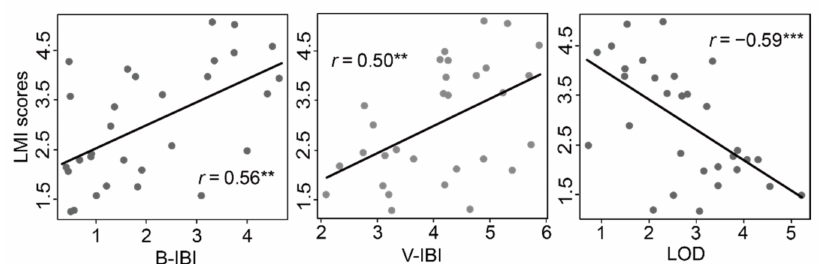
Figure 7. Relationship of the landscape-based multi-metric index (LMI) scores with benthic macroinvertebrate-based index of biotic integrity (B-IBI), vegetation-based index of biotic integrity (V-IBI), and local disturbance index (LOD). Black lines show linear fits. ** p < 0.01; *** p <